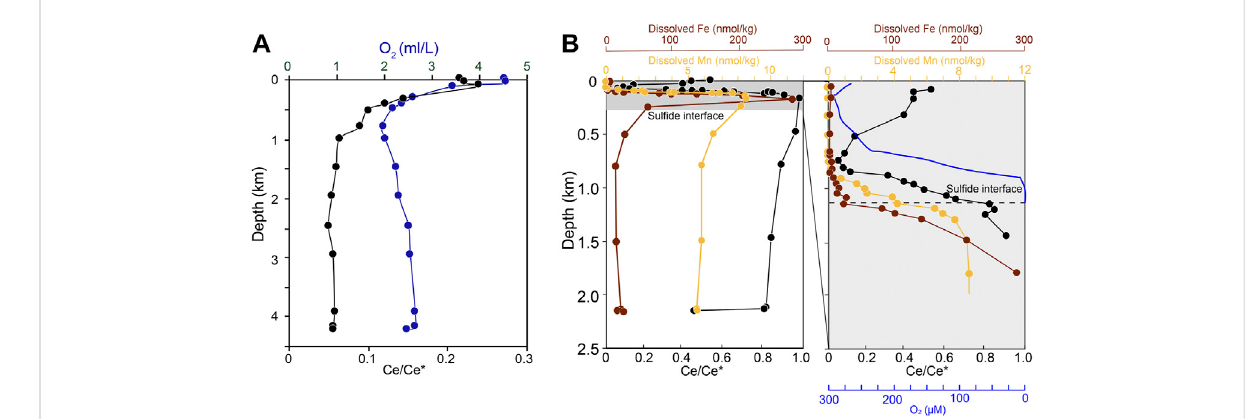
FIGURE 3 Vertical pro fi les of dissolved oxygen content (blue) and Ce anomaly (Ce/Ce* = Ce*Nd/Pr 2 ) (black) for one station in the (A) South China Sea (Alibo and Nozaki, 2000)and (B) theBlack sea (German etal., 1991).Here weuse Ce/Ce*= Ce ×La/Nd 2 to calculate theCe anomalyin theBlack Sea because Pr concentration was not